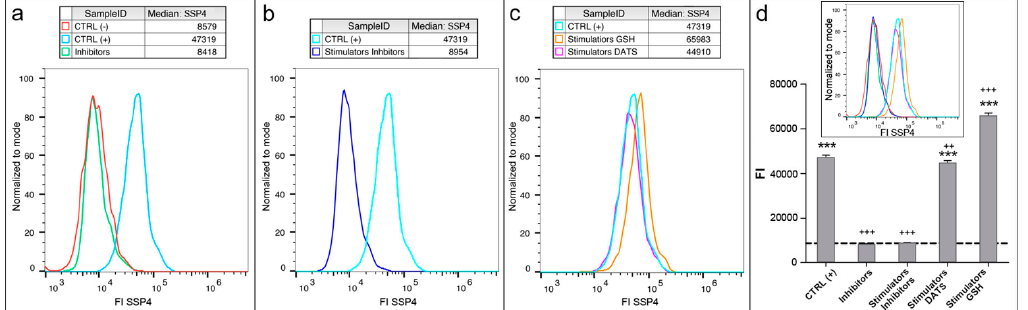
Figure 7. Detection of sulfane sulfur species using flow cytometry: ( a – c ) Spectrum of SSP4 fluorescence intensity, emitted in presence of sulfane sulfurs, in endothelial cells treated for 3 h. ( d ) FI median values are drawn in the histogram plot, where untreated control, CTRL ( − ), is indicated as a dashed baseline. ( d ) Inset is a merge of graphs in ( a – c ) to allow easier comparison of the relevant data. Data are depicted as mean ± SD; p value versus untreated control: *** p < 0.001, while p value versus CTRL (+): ++ p < 0.01 , +++ p < 0.001 (according to Student’s two-tailed t -test). CTRL (+)/Stimulators; 5 mM Cys, 5 mM vitamin B6, 10 µ M SAM. Inhibitors; 2 mM DL-PAG and AOAA. FI; fluorescence intensity. Color code is the same in ( a – c ) and the inset of ( d